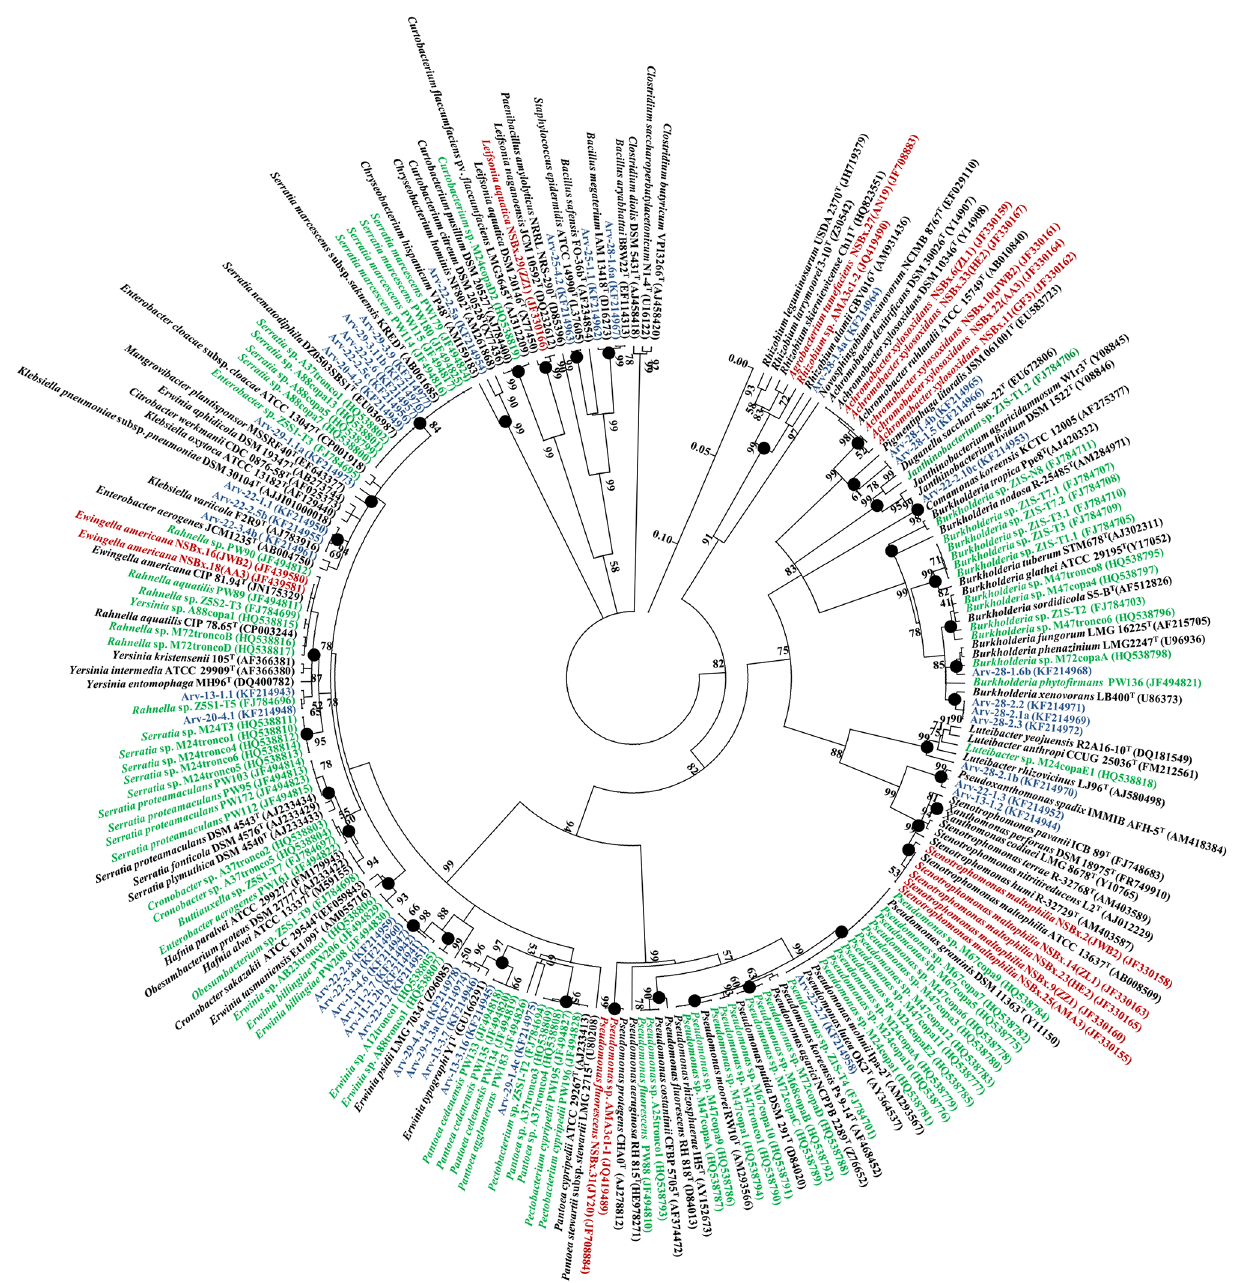
Figure 2. Phylogenetic analysis of bacterial 16S rRNA gene sequences of bacteria carried by PWN obtained from different countries (China - red, Portugal - green; USA - blue) and sequences available from NCBI. The circular tree was generated using a neighbor-joining analysis included in MEGA 5 software, partial deletion (95%), linearized and rooted by Clostridium spp. Symbol ( when the tree was reconstructed using the maximum likelihood (RAxML). The numbers on the tree indicate the percentages of bootstrap sampling, derived from 1,000 replications, values below 50% are not shown. Isolates characterized in this study are indicated in blue. Scale bar, 5 inferred nucleotide substitutions per 100 nucleotides.